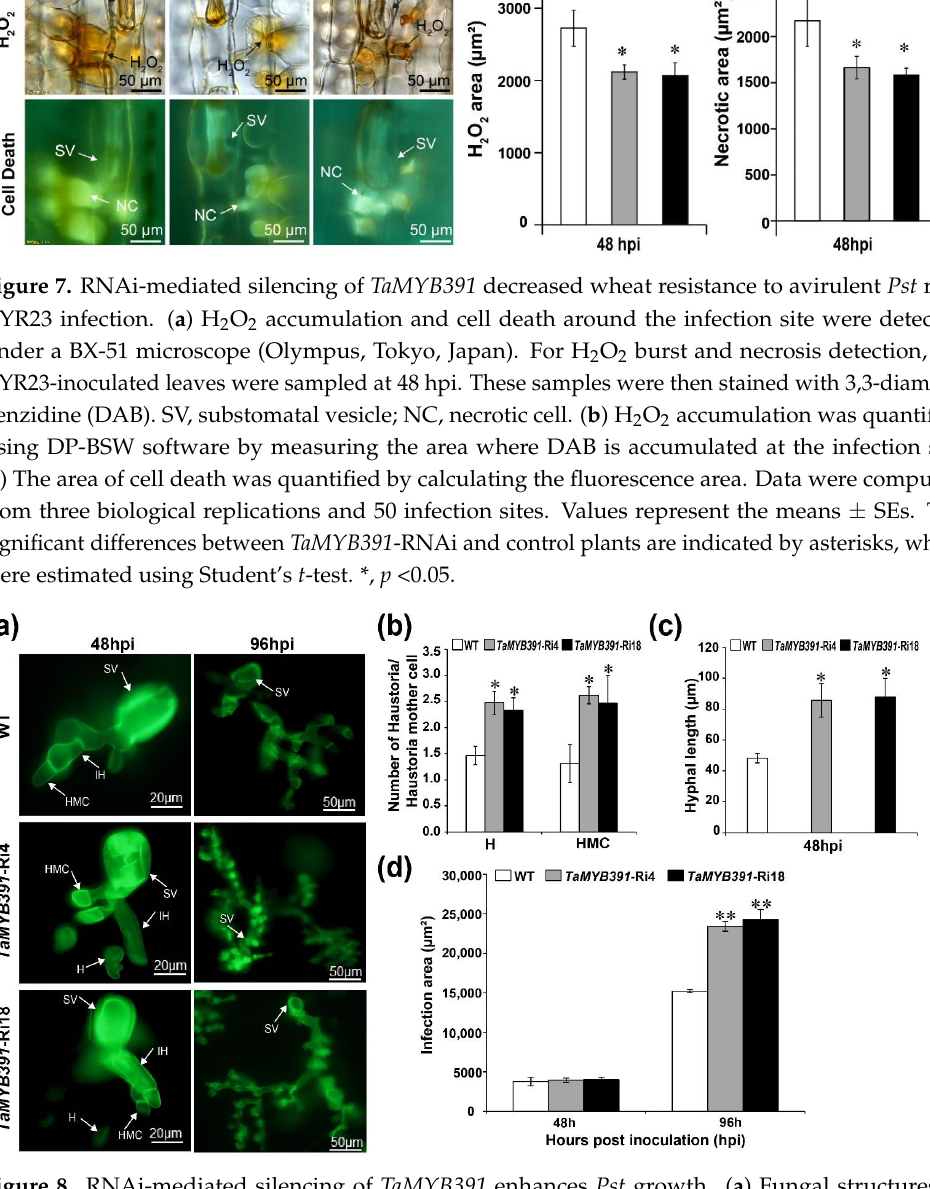
Figure 8. RNAi-mediated silencing of TaMYB391 enhances Pst growth. ( a ) Fungal structures in TaMYB391 -RNAi and control plants challenged with the avirulent Pst race CYR23. Leaves inoculated with Pst were sampled at 48 and 96 hpi. Samples were then stained with wheat germ agglutinin (WGA) for fungal growth detection. Microscopy detection of different structures of Pst was performed by using an Olympus BX-51 microscope. SV, sub-stomatal vesicle; IH, infection hypha; HMC, haustorial mother cells; H, haustoria, WT, wild type. ( b ) The average number of haustoria and haustorial mother cells per infection site. ( c ) Hyphal length as measured from the juncture of the hypha and substomatal vesicle to the tip of the hypha. A DP-BSW tool (Olympus) was used to compute the hyphal length. ( d ) The colony area per each infection site as measured by the DP-BSW tool (Olympus). Data were computed from three biological replications and 50 infection sites. Values represent the means ± SEs. Significant differences between TaMYB391 -RNAi lines and control plants were estimated using Student’s t -test and indicated by asterisks. *, p < 0.05; **, p < 0.01.